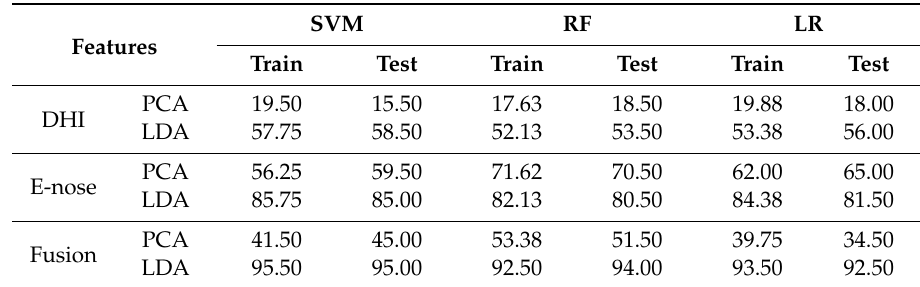
Table 2. Accuracy (mean of five-fold cross-validation) in milk source identification based on PCA and LDA